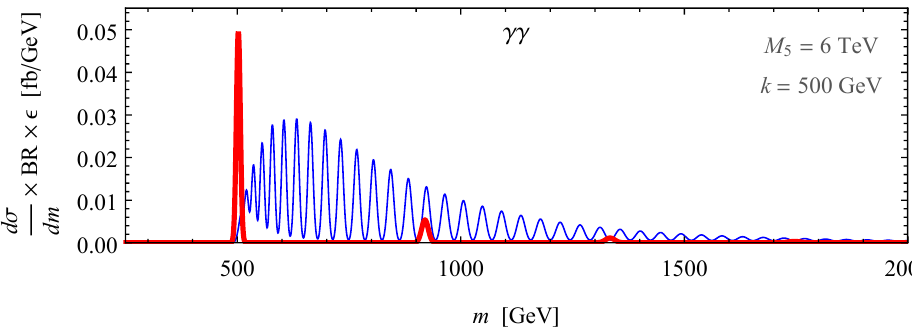
Figure 18 . Comparison between the diphoton spectra of the KK gravitons in CW/LD (thin blue, as in (cid:12)gure 12) and the RS model (thick red), after the RS curve has been scaled down by a factor of 30 for presentation purposes. The parameters of the RS model were chosen such that the values of M 5 and the mass of the (cid:12)rst KK mode, m 1 , are the same in both models. The latter is obtained by setting k RS (cid:25) 0 : 26 k .